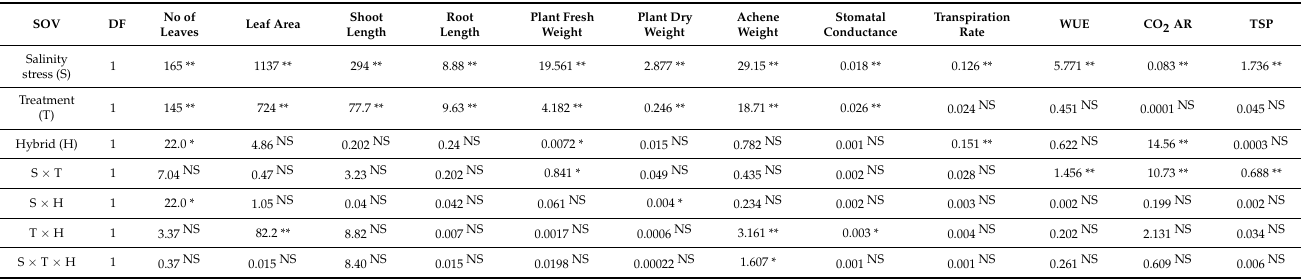
Table 1. Mean sum of the squares of growth and the physiological parameters of sunflower hybrids grown under salinity stress environments in response to foliar applied potassium.